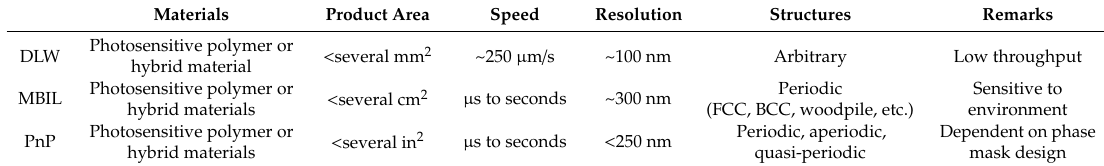
Table 1. Technical comparison of unconventional optical 3D